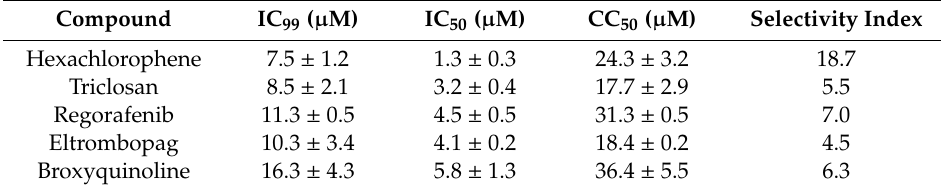
Table 1. Anti-SFTSV activity and cytotoxicity of five selected drug compounds.